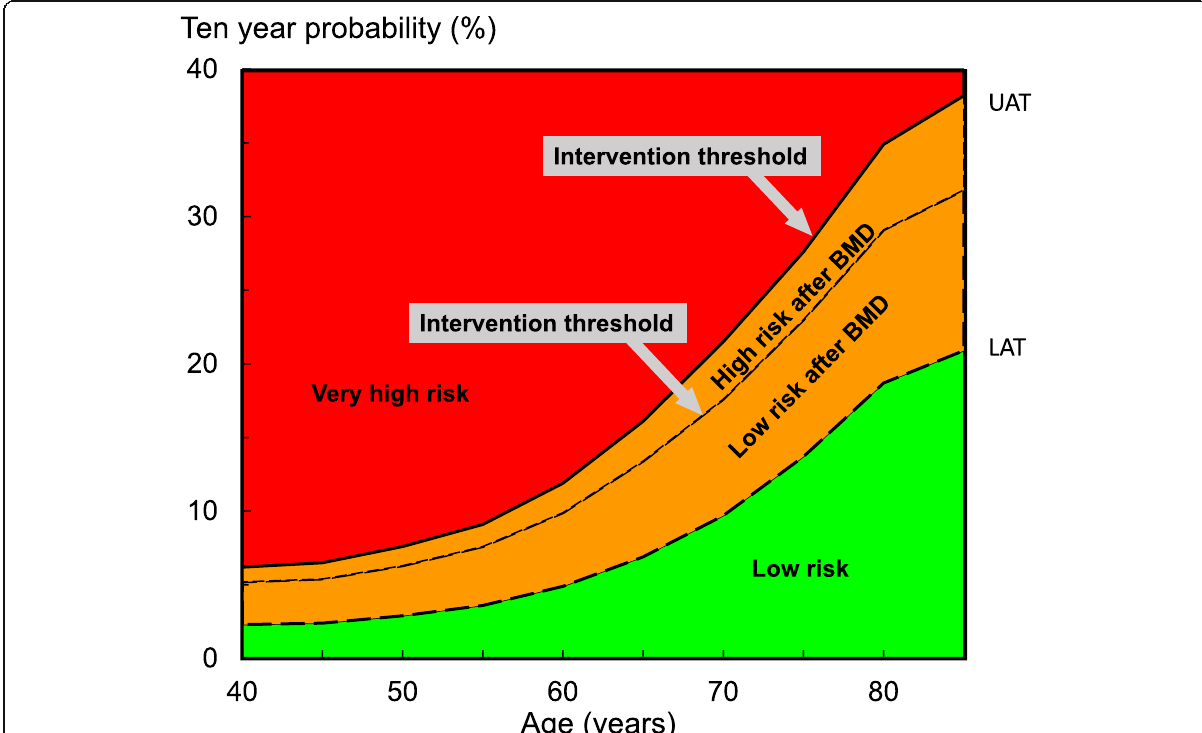
Fig. 1 Infographic outlining the four osteoporosis risk categories. Initial risk assessment relies on using FRAX with clinical risk factors alone. Two intervention thresholds are identified. FRAX probability in the red zone, above intervention threshold (2) indicates very high risk. For this group of people, an initial course of anabolic therapy followed by anti-resorptive treatment may be appropriate. FRAX probability in the green zone suggests low risk, with advice to be given regarding lifestyle, calcium, and vitamin D supplementation. FRAX probability in the intermediate (yellow) zone should be followed by BMD assessment and recalculation of FRAX probability including femoral neck BMD. After recalculation, if the risk got in the red zone above intervention threshold 2, this indicates very high-fracture risk, whereas if the risk got in between intervention threshold 1 and below intervention threshold 2, this would indicate high risk, which suggests initial anti-resorptive therapy. If the risk lies below the intervention threshold 1, this would indicate low risk (management would be similar to green zone. Patients with a prior fragility fracture are designated either at high risk or possibly at very high risk dependent on the FRAX probability (amended from Fig. 1 published in Kanis, J.A., Harvey, N.C., McCloskey, E. et al. Algorithm for the management of patients at low, high and very high risk of osteoporotic fractures.